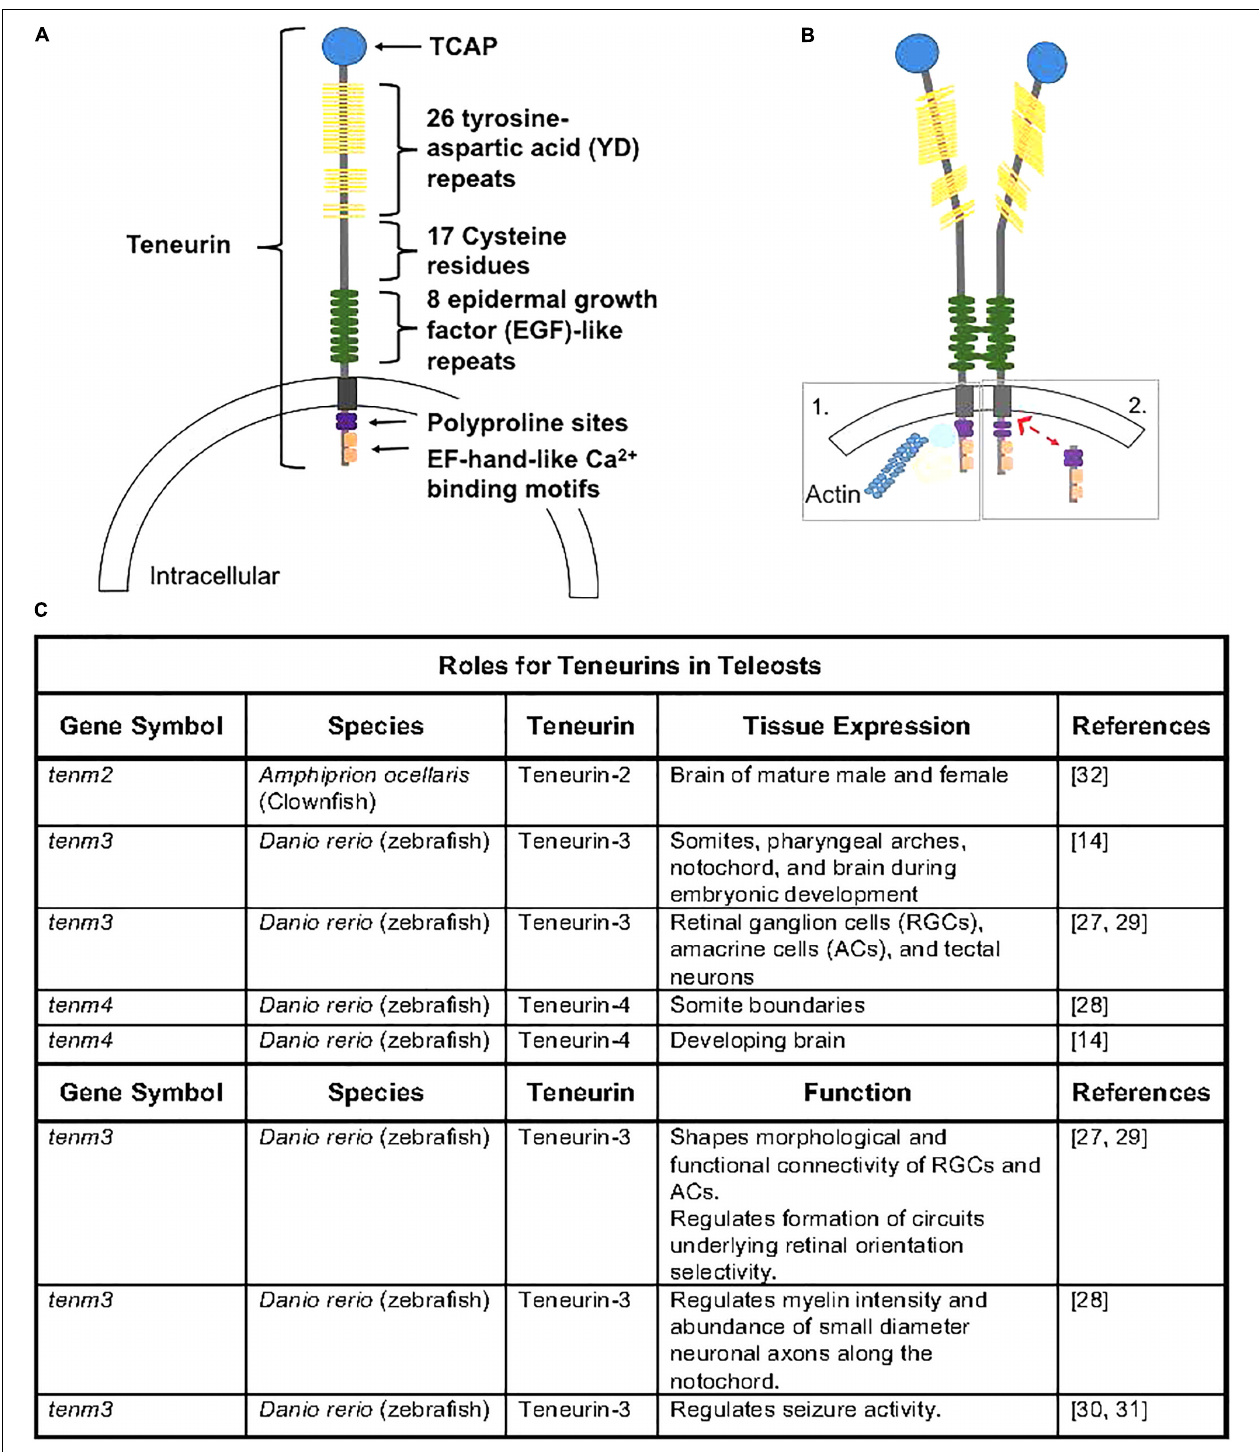
FIGURE 1 | (A) Teneurin peptides are highly conserved and contain an intracellular domain that contains polyproline cites and EH-hand-like Ca 2 + binding cites, a transmembrane domain, and an extracellular domain containing 8 epidermal growth factor-like repeats, 17 cystein residues, 26 tyrosine-aspartic acid repeats, and a teneurin c-terminal associated peptide (TCAP). Figure rendered from Tucker and Chiquet-Ehrismann (2006) and Woelfle et al. (2015). (B) Teneurins can dimerize via EGF-like repeats (2 and 5), causing conformational changes that can lead to homophillic binding with neighboring cells. Following dimerization, the intracellular domain can anchor to the cytoskeleton (1) or can be cleaved (2) and translocate to the nucleus where it can interact with transcriptional regulators (Woelfle et al., 2015). (C) Outline of teneurins and TCAPs gene expression and functional analyses from teleost species.